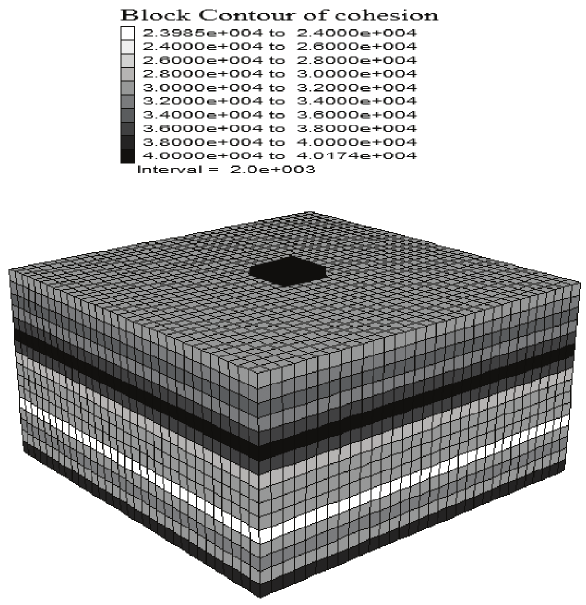
Fig. 4. Typical realization of random field